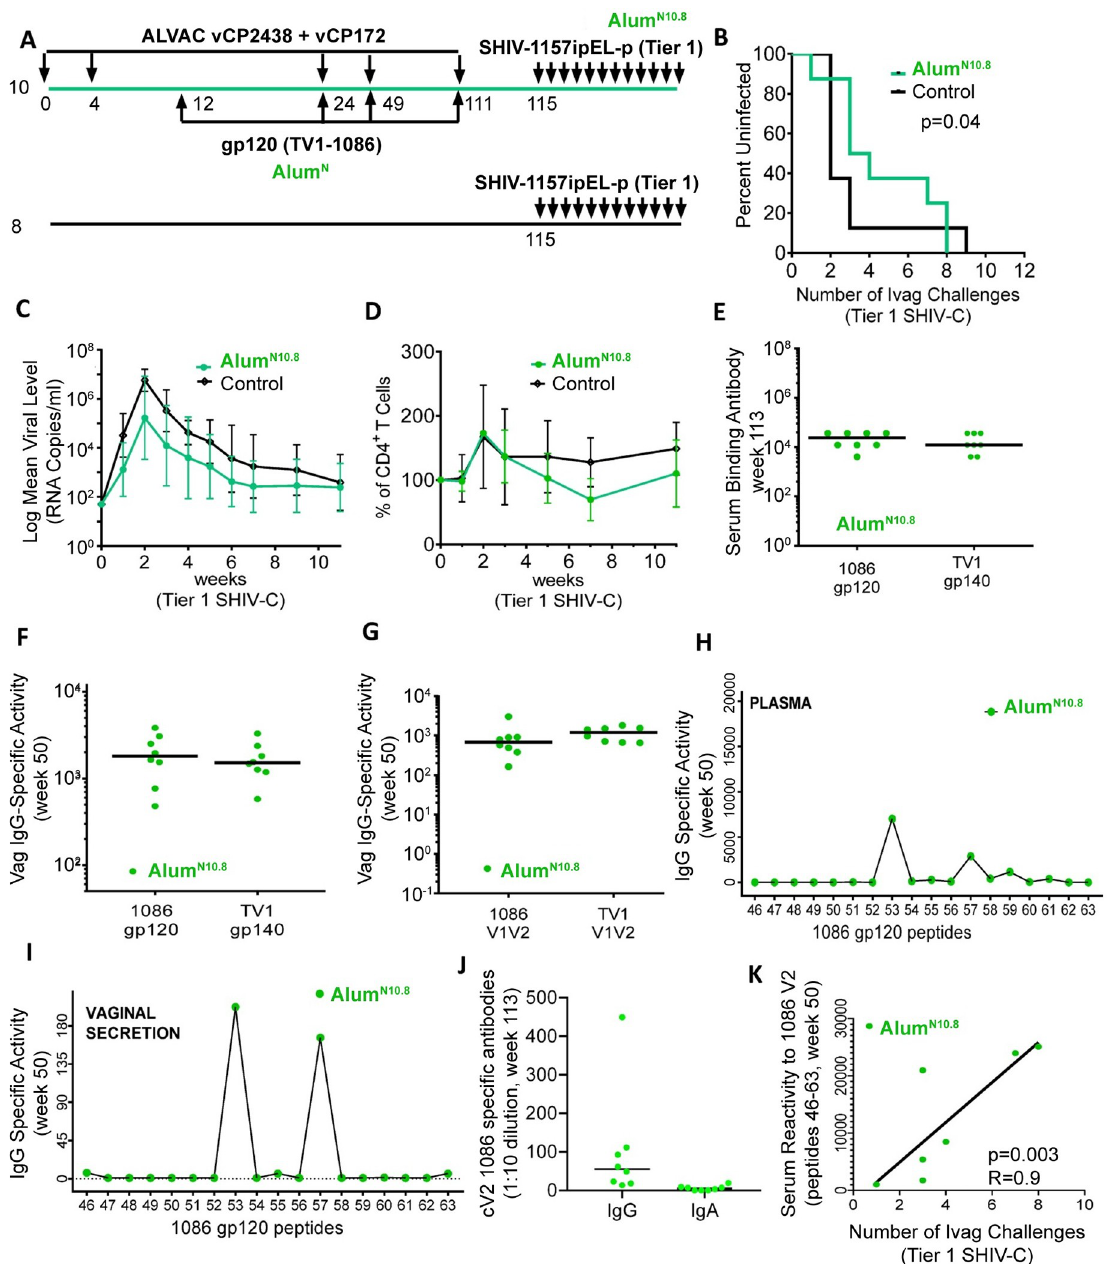
Fig 2. Relative efficacy and immunogenicity of the Alum N10.8 regimen. Unless stated otherwise, all assays, experiments and graphs associated with the Alum N10.8 study are represented by full green circles, and the number of available samples (i.e., those not depleted in other experiments) are shown as stated in the legend. (A) Animals were immunized with ALVAC-vCP172 and ALVAC-cVCP2438 and boosted 4 times with 100 μ g each of the monomeric TV1 and 1086 gp120 proteins (800 μ g total). Each dose was formulated with 2.16 mg of Aluminum Hydroxide (Alum N10.8 ; Table 1). Three of four boosts were administered together with the ALVAC vectors (Alum N10.8 ; n = 10). Only 8 out of 10 vaccinated animals survived up to the Tier 1 SHIV-C challenge. Controls (n = 8; were left na ï ve. (B) The rate per exposure of Tier 1 SHIV-C (SHIV-1157ipEL-p) acquisition was compared between 8 vaccinated animals and 8 controls using the log-rank test of the discrete-time proportional hazards model. (C) Geometric mean of SHIV-C RNA levels in plasma of 8 vaccinated and 8 control animals that became infected. (D) Mean percentage of CD4 + T cell changes in blood (after infection in 8 vaccinated and 8 control animals. (E) Serum reactivity to 1086 gp120 and TV1 gp140 in 8 vaccinated animals at week 113 (two weeks after last immunization). (F) Vaginal IgG-specific activity to 1086 gp120 and TV1 gp140 in 8 vaccinated animals at week 50. (G) Vaginal IgG-specific activity to 1086 and TV1 V1/V2 scaffolds in 8 vaccinated animals at week 50. Mean IgG specific-activity to the 18 overlapping linear peptides encompassing the 1086 V2 measured in the (H) plasma or (I) vaginal secretions of 9 vaccinated animals at week 50 (see S3A Fig for data from each animal).